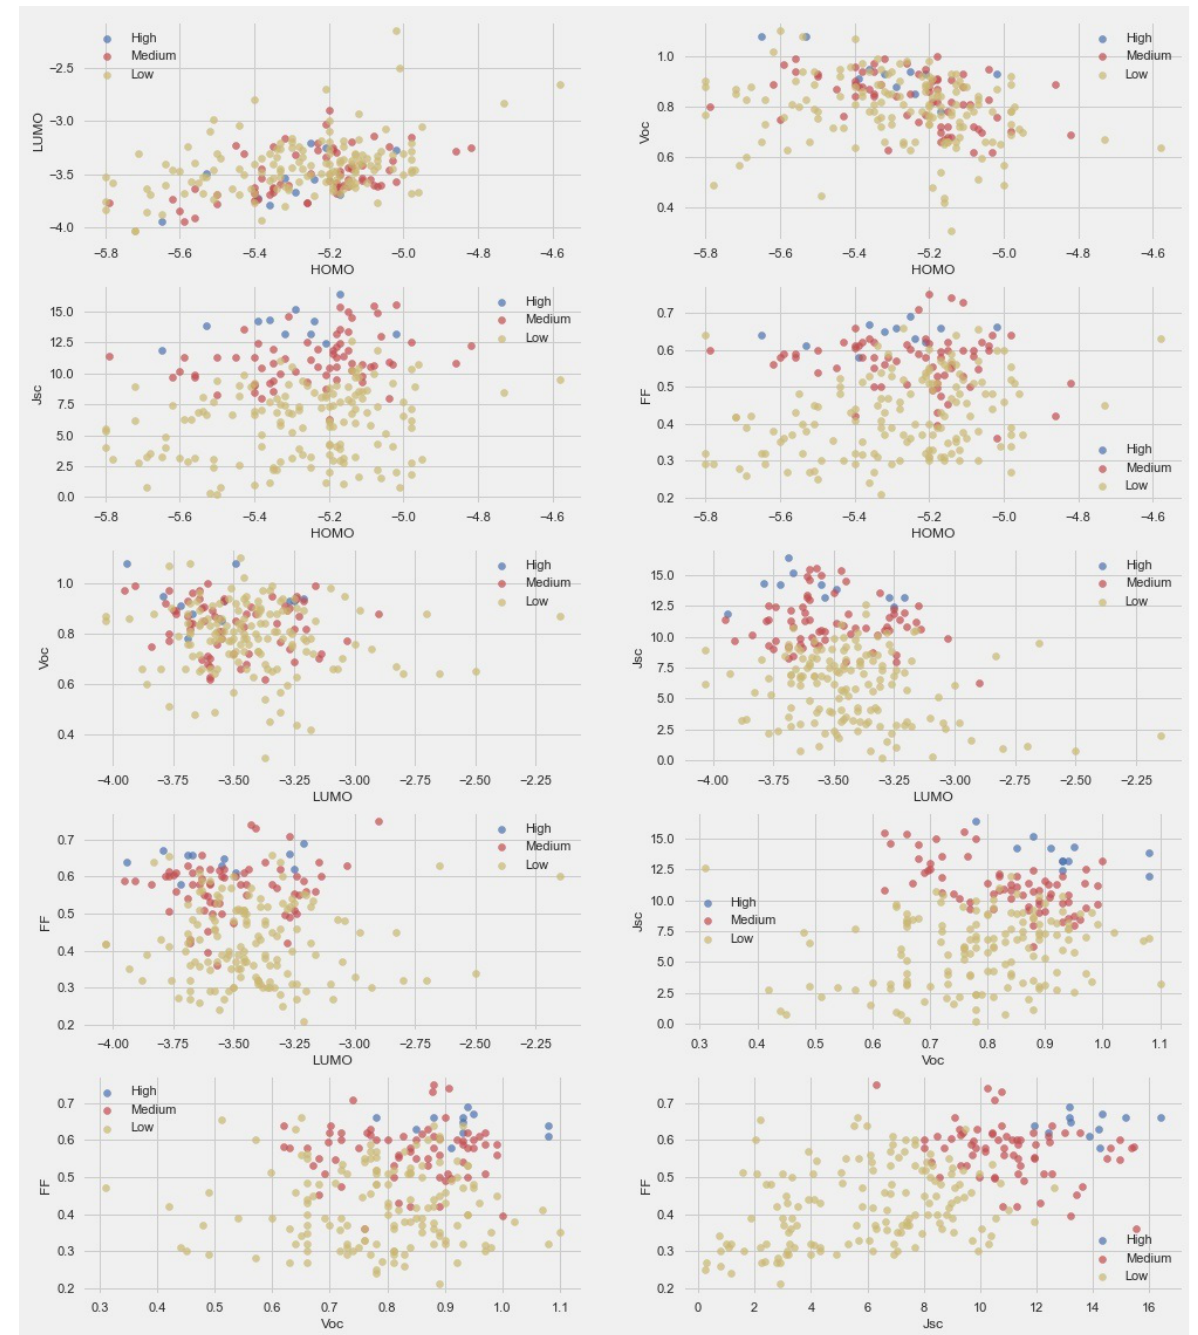
Figure 2. Pair-scatter plot between the parameters in dataset. The box plot allowed us to look at the data in another way. The box plots for different parameters are given in Figure 3. In the case of HOMO, the majority of PCE points were boxed between −5 .1 and − 5.4 eV. The small-size box for a high PCE indicates that the con- trol of the HOMO level of donors can help to achieve a high PCE. In the case of LUMO, the size of boxes was almost the same in all categories. In the cases of Jsc, Voc, and FF, the size of boxes was very small for a high PCE.